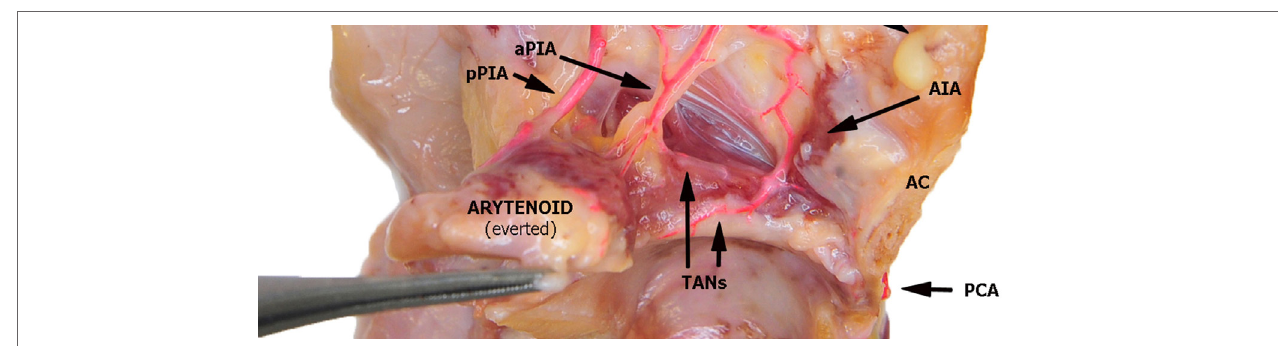
Figure 5 | Left fresh-frozen cadaver hemilarynx after midline section of the cricoid and thyroid cartilages, seen from above. The ipsilateral arytenoid had been everted while left aryepiglottic and false vocal folds had been removed. Paraglottic fat tissue and vocal muscle are still mostly in place. Bicomponent red silicone had been injected in the left common carotid and subclavian arteries. Abbreviations: AIA, antero-inferior artery; aPIA, anterior branch of the postero-inferior artery; pPIA, posterior branch of the postero-inferior artery; AC, anterior commissure; PCA, paracommissural branch of the crico–thyroid artery; TANs, lateral and medial transverse anastomotic